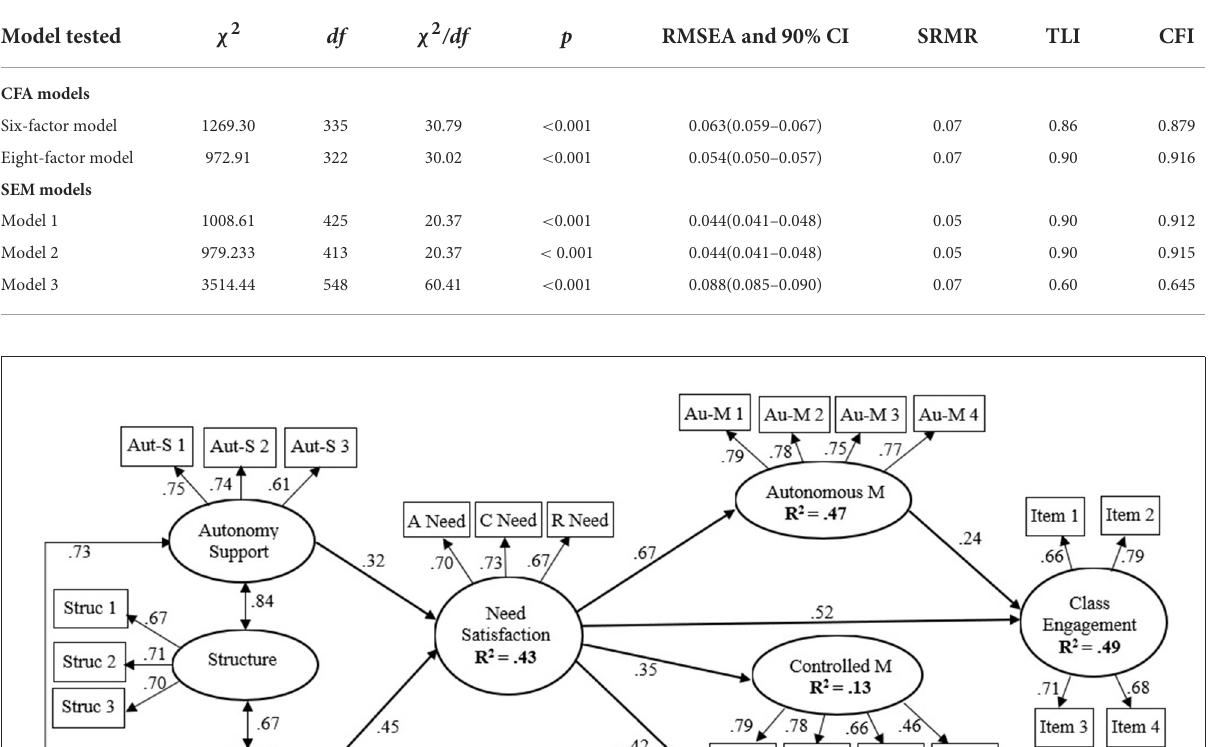
TABLE 3 Fit statistics for the models.